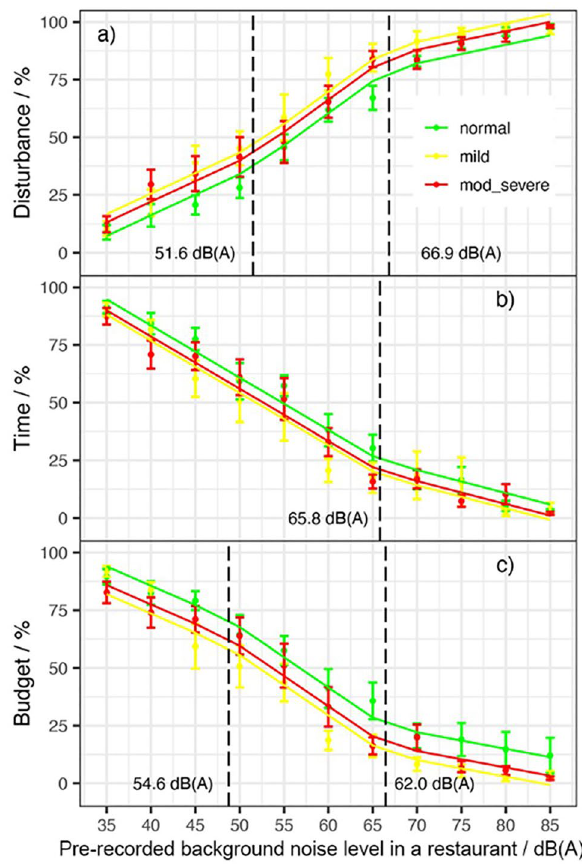
Figure 2. Relationship between the pre-recorded background noise level in a restaurant in dB(A) and self- reported communication disturbance ( a ), willingness to spend time ( b ), and willingness to spend money ( c ), where the error bands indicate the standard error. Vertical dashed lines mark the change-points.